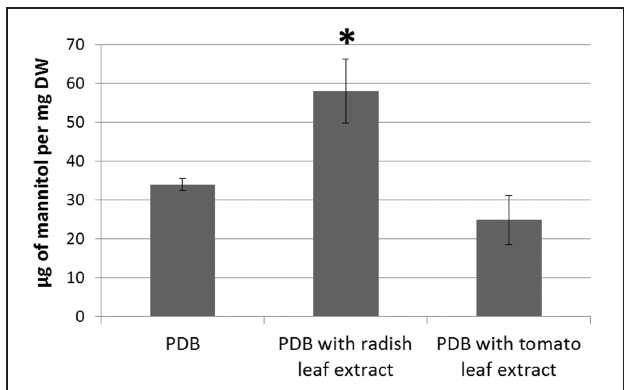
FIGURE 10 | HPLC assay of intracellular mannitol extracted from the mycelium of the wild-type genotype Abra43 grown in PDB supplemented or not with tomato or radish leaf extract (10% v/v) for 7 days. Data represent the means of three independent experiments and error bars indicate standard deviations. Asterisks indicate a significant difference from the control culture conditions (PDB only) using the Student test ( P < 0 .